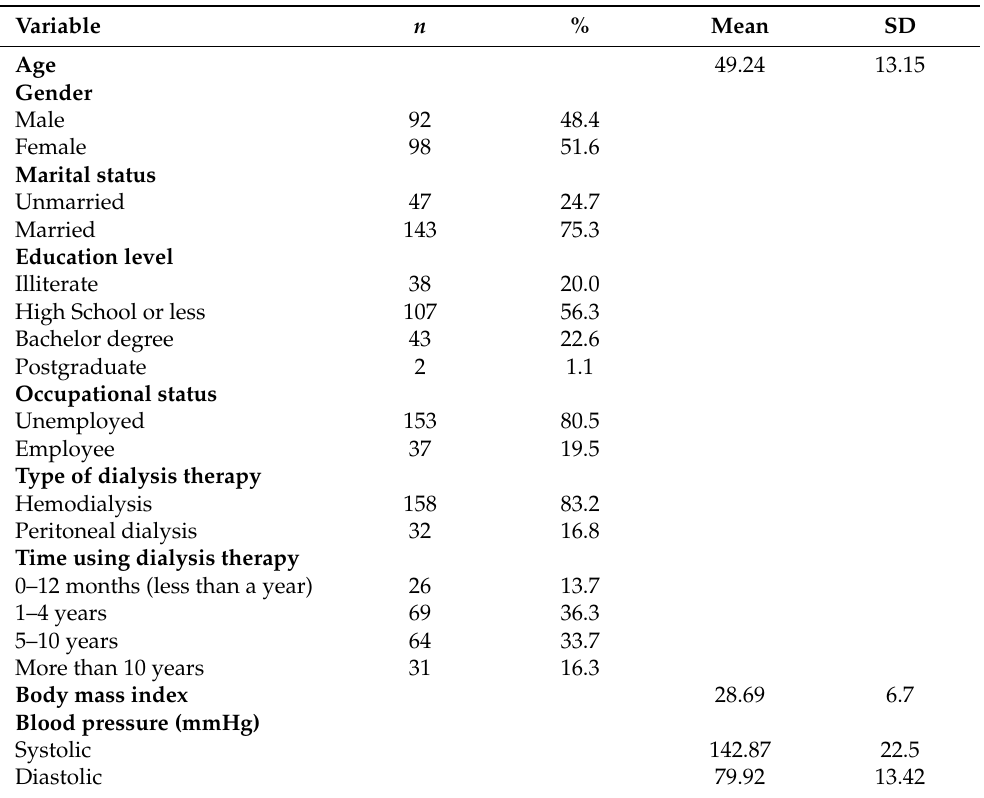
Table 1. Characteristics of the study population, n = 190.